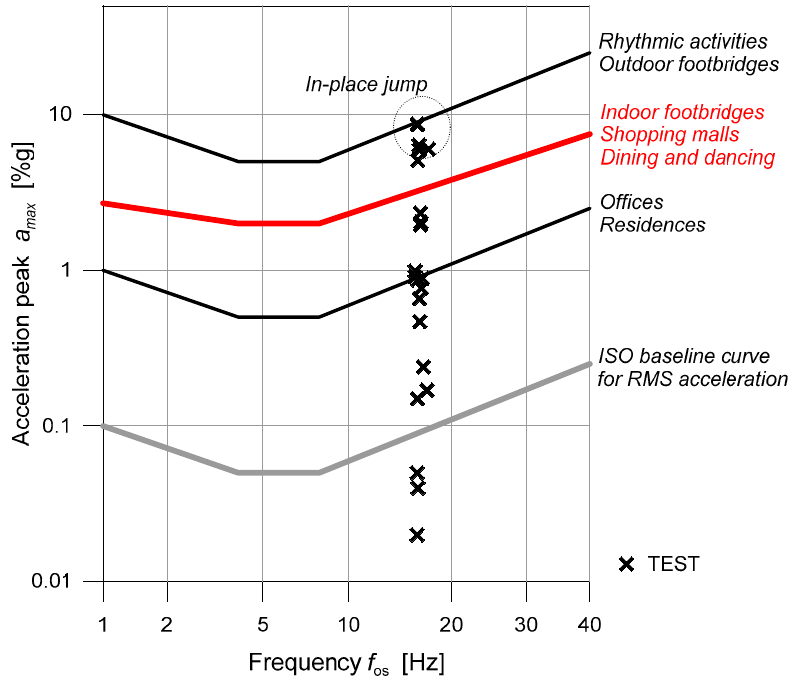
Figure 11. Vibration serviceability assessment of the examined system, based on ISO recommended limits. Experimental acceleration peaks (average values, vertical direction), as a function of the corresponding frequency.